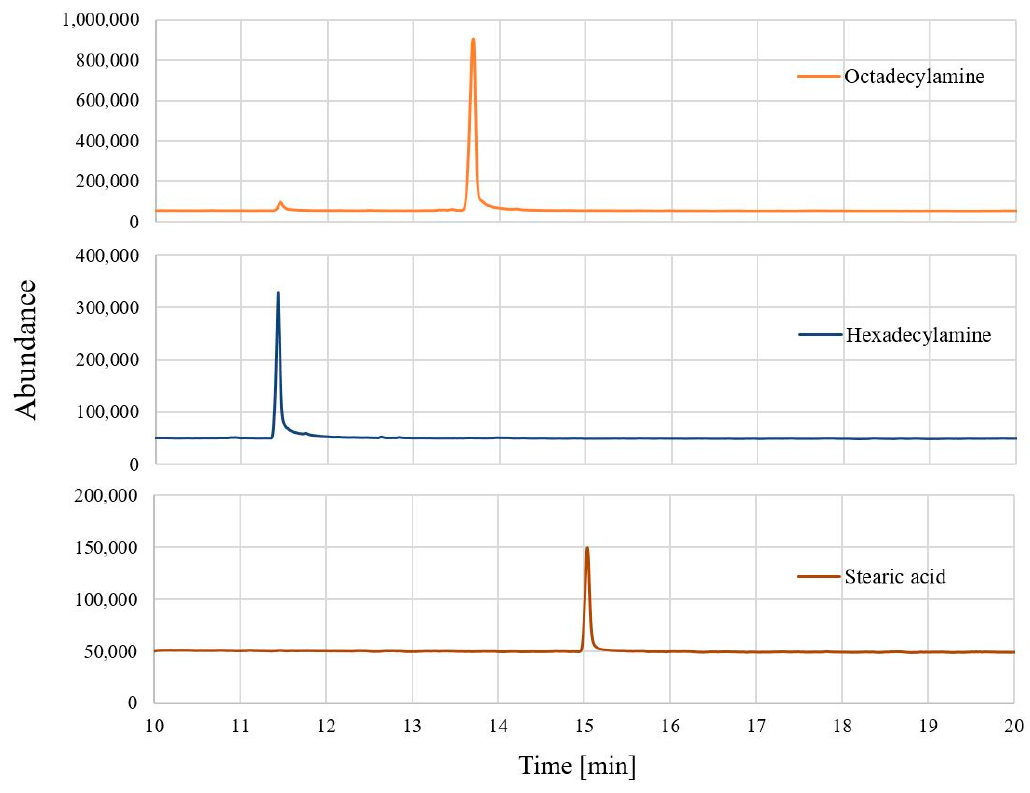
Figure 2. Chromatograms of the standards.